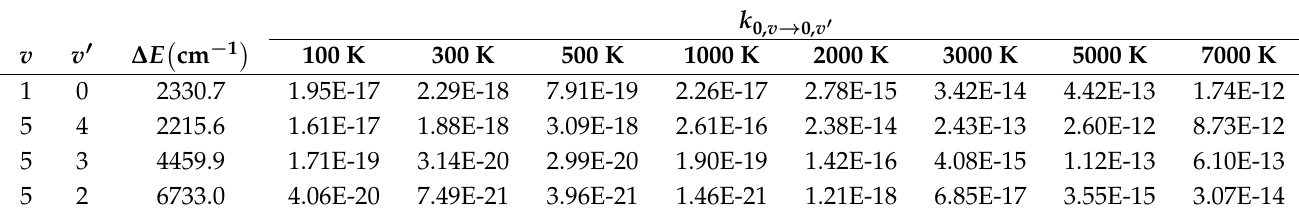
Table 13. Multiquantum V–T/R rate coefficients (in cm 3 /s) for the transition CO ( 1 ) + N 2 ( v ) → CO ( 1 ) + N 2 ( v (cid:48) ) + ∆ E .